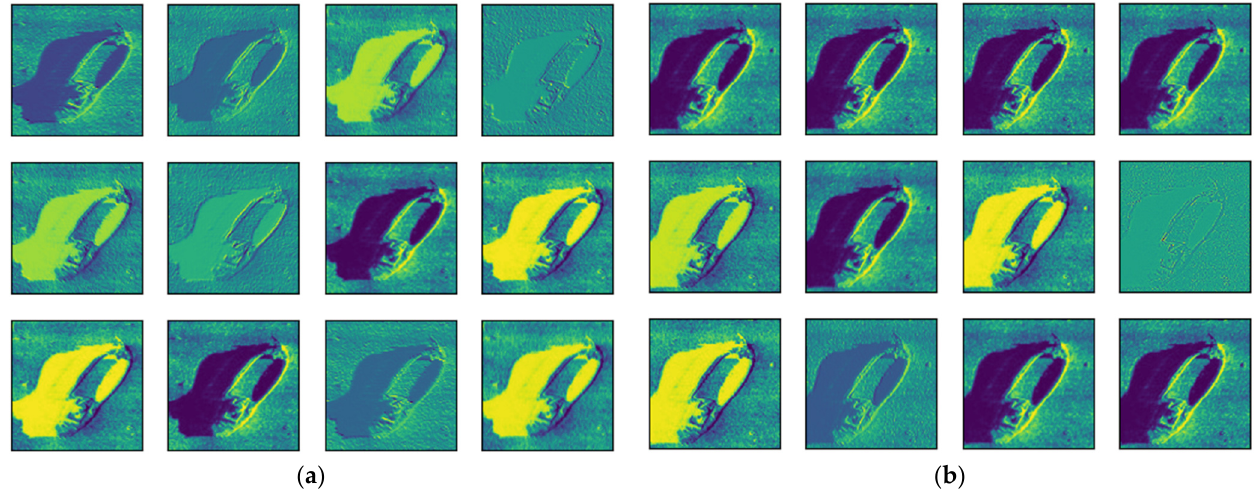
Figure 9. The first 12 channel images in the first convolution layer of ( a ) vgg19 and ( b ) pre-trained vgg19.